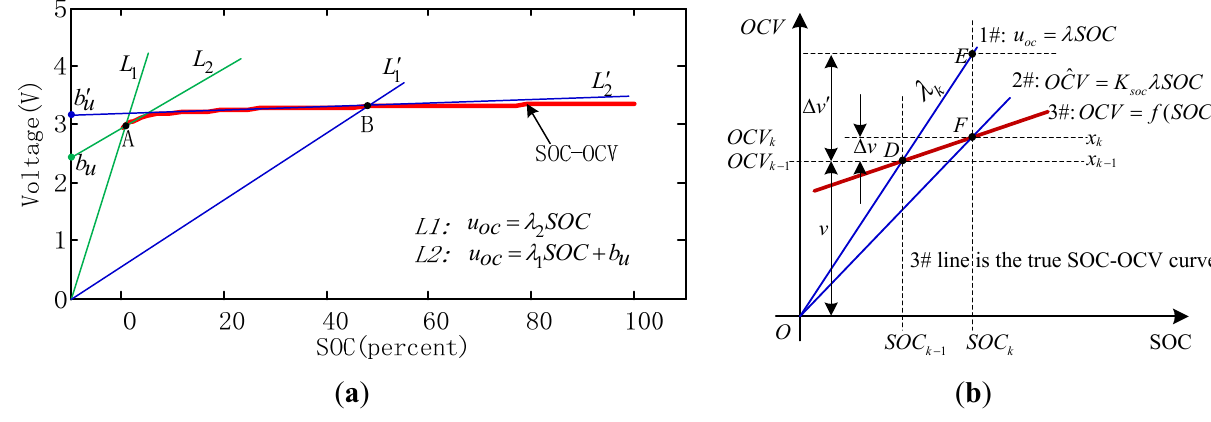
Figure 3. Linearizing the SOC-OCV curve: ( a ) Examples of linearization; ( b ) Principle of